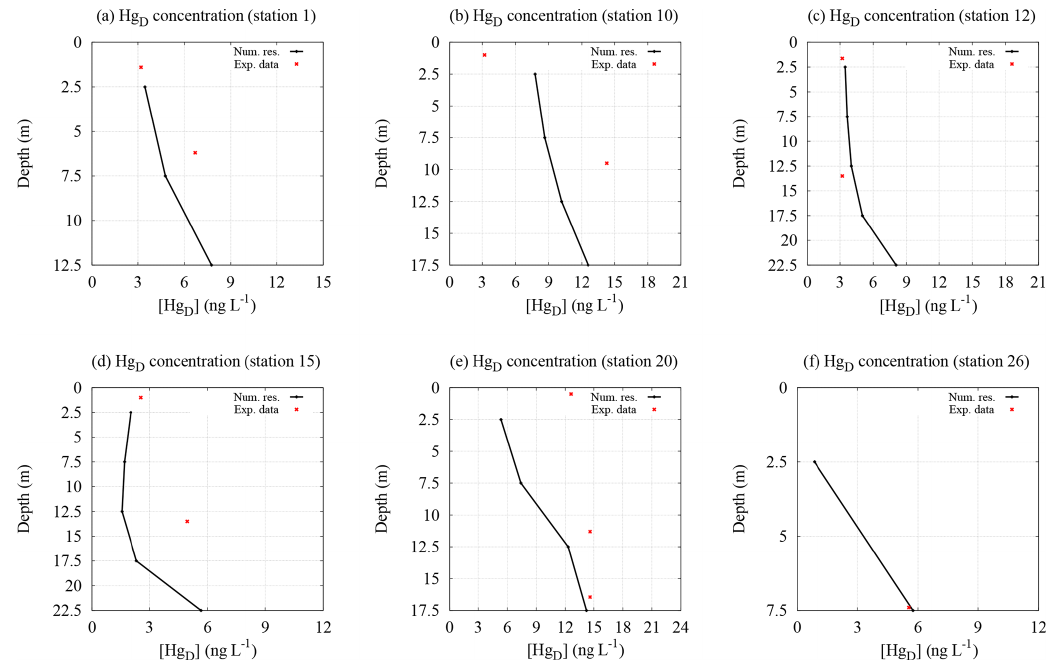
Figure 4. Comparison between the experimental data (red points) and the theoretical results (black lines) for the dissolved mercury concen- tration at six stations in the Augusta Bay. The vertical profiles of [ Hg D ] are obtained by the model for the sites closest to stations 1, 10, 12, and 20 (sampling May 2011), station 15 (sampling June 2012), and station 26 (sampling February